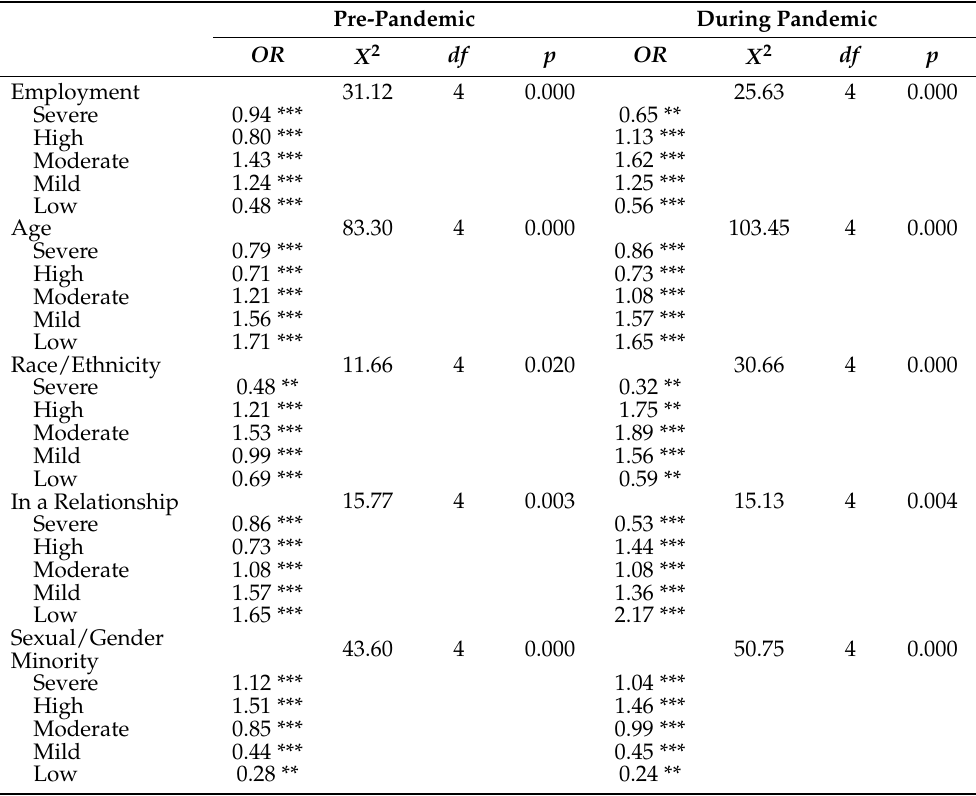
Table 4. Wald tests ( X 2 ) and odds ratios (OR) for the effects of covariates on pre-COVID and post- COVID latent profile membership. Pre-Pandemic During Pandemic OR X 2 df p OR X 2 df p Employment 31.12 4 0.000